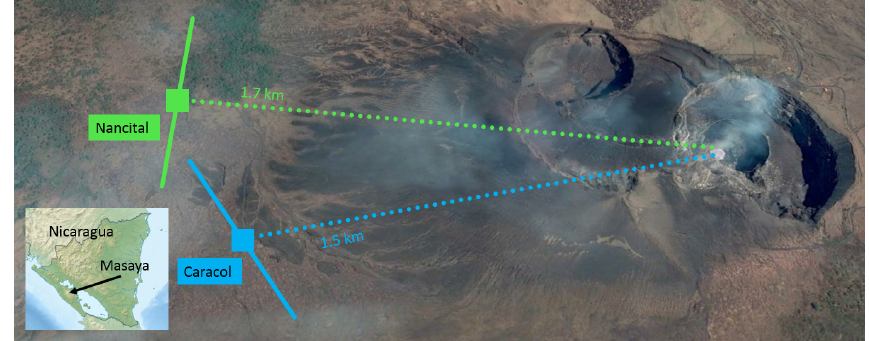
Figure 1. Location and scan geometries of the NOVAC stations Caracol and Nancital at Masaya volcano. Coloured squares indicate the instrument location and solid lines the scan direction. For further parameters, see Table 1. The map was created with graphical material from https://commons.wikimedia.org/wiki/File:Nicaragua_relief_location_map.jpg (last access: 9 June 2021) and from © Google